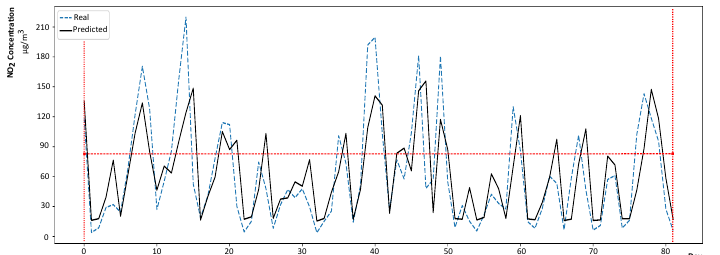
Figure 14. Predicted and actual de-normalized output values with the VSCA model and using the validation set. Notes: the dotted red horizontal line clarifies the mean value of the target, de-normalized output values correspond to the 24 h average of NO 2 concentration levels in the atmosphere and the validation set consists of 81 consecutive